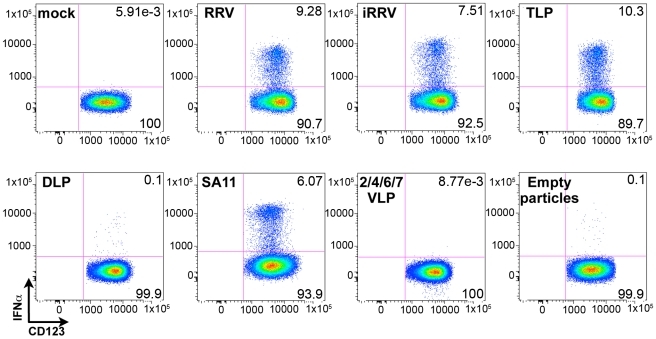
Viral determinants of IFNα induction.Representative FACS plots of IFNα production by pDCs at 12 hours post exposure to rotavirus-derived stimuli. RRV: live virus; iRRV: inactivated virus; TLP: purified triple-layered (2/4/6/7) genome-containing virus particles; DLP: purified double-layered (2/6) genome-containing virus particles; SA11: live virus strain from which VLPs are derived; 2/4/6/7 VLPs: recombinant genome-free virus-like particles; empty particles: purified genome-free TLPs.